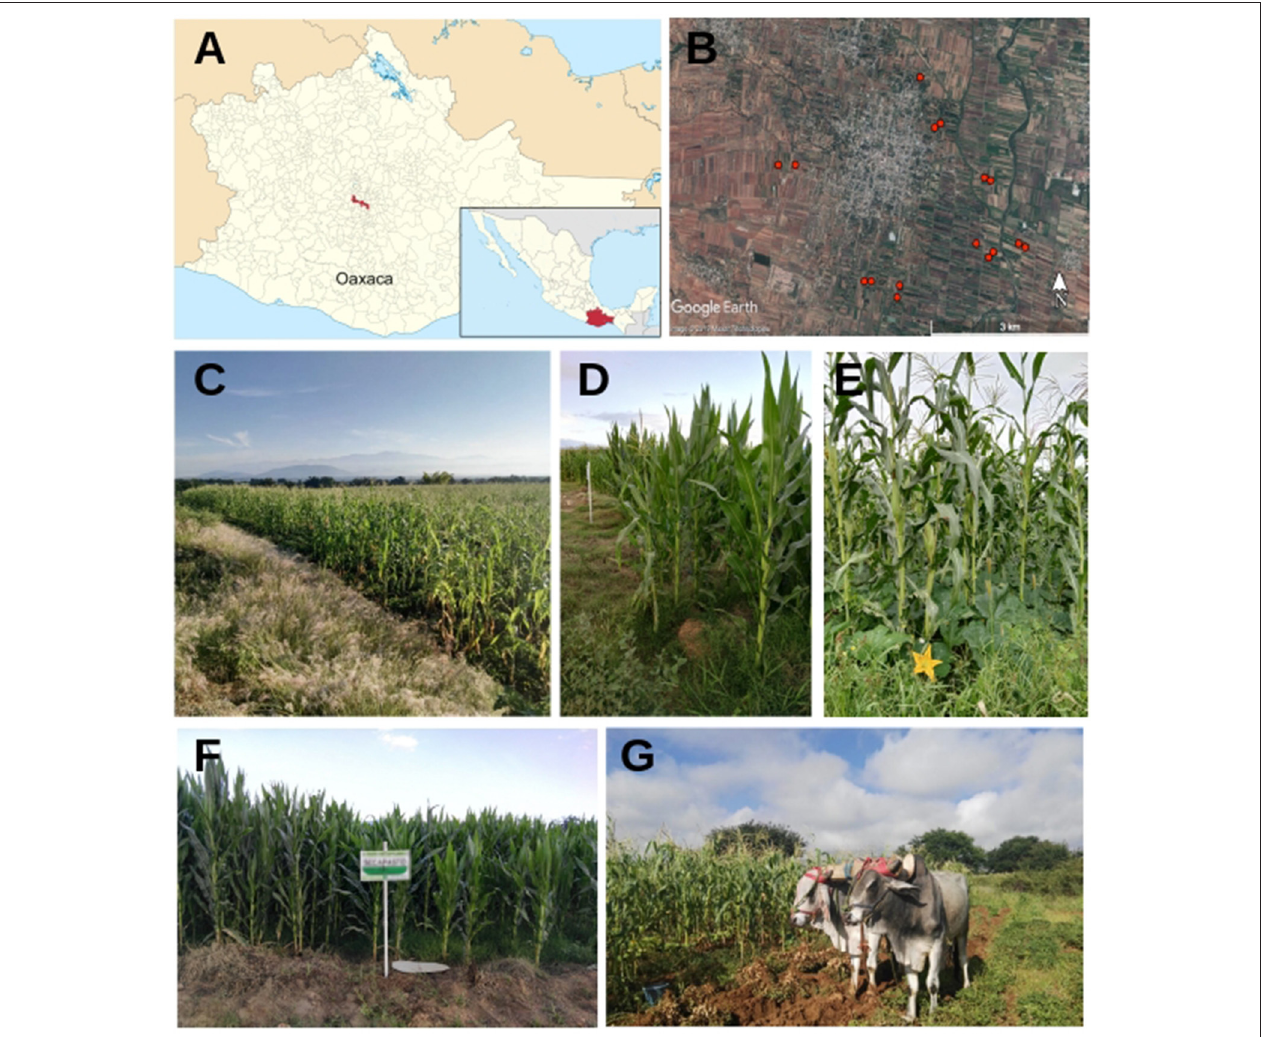
FIGURE 1 | Maize-based agricultural systems in the study site. The plots were selected in the municipality of Zaachila, Oaxaca (A) as neighboring pairs with contrasting types of management, as suggested by our informers (B) . The management practices were diverse and ranged from low-input polycultures to high-input monocultures (C–G) . (D,F) illustrates more industrialized plots in which maize is grown in monoculture and with the use of external and commercial inputs. (C,E,G) illustrate more traditional plots exhibiting a maize-based polyculture called milpa, as well as animal traction. Sources: Wikimedia commons ID 360701525 and 284784087 (A) , Google Earth (B) and personal photographs (C,D) .